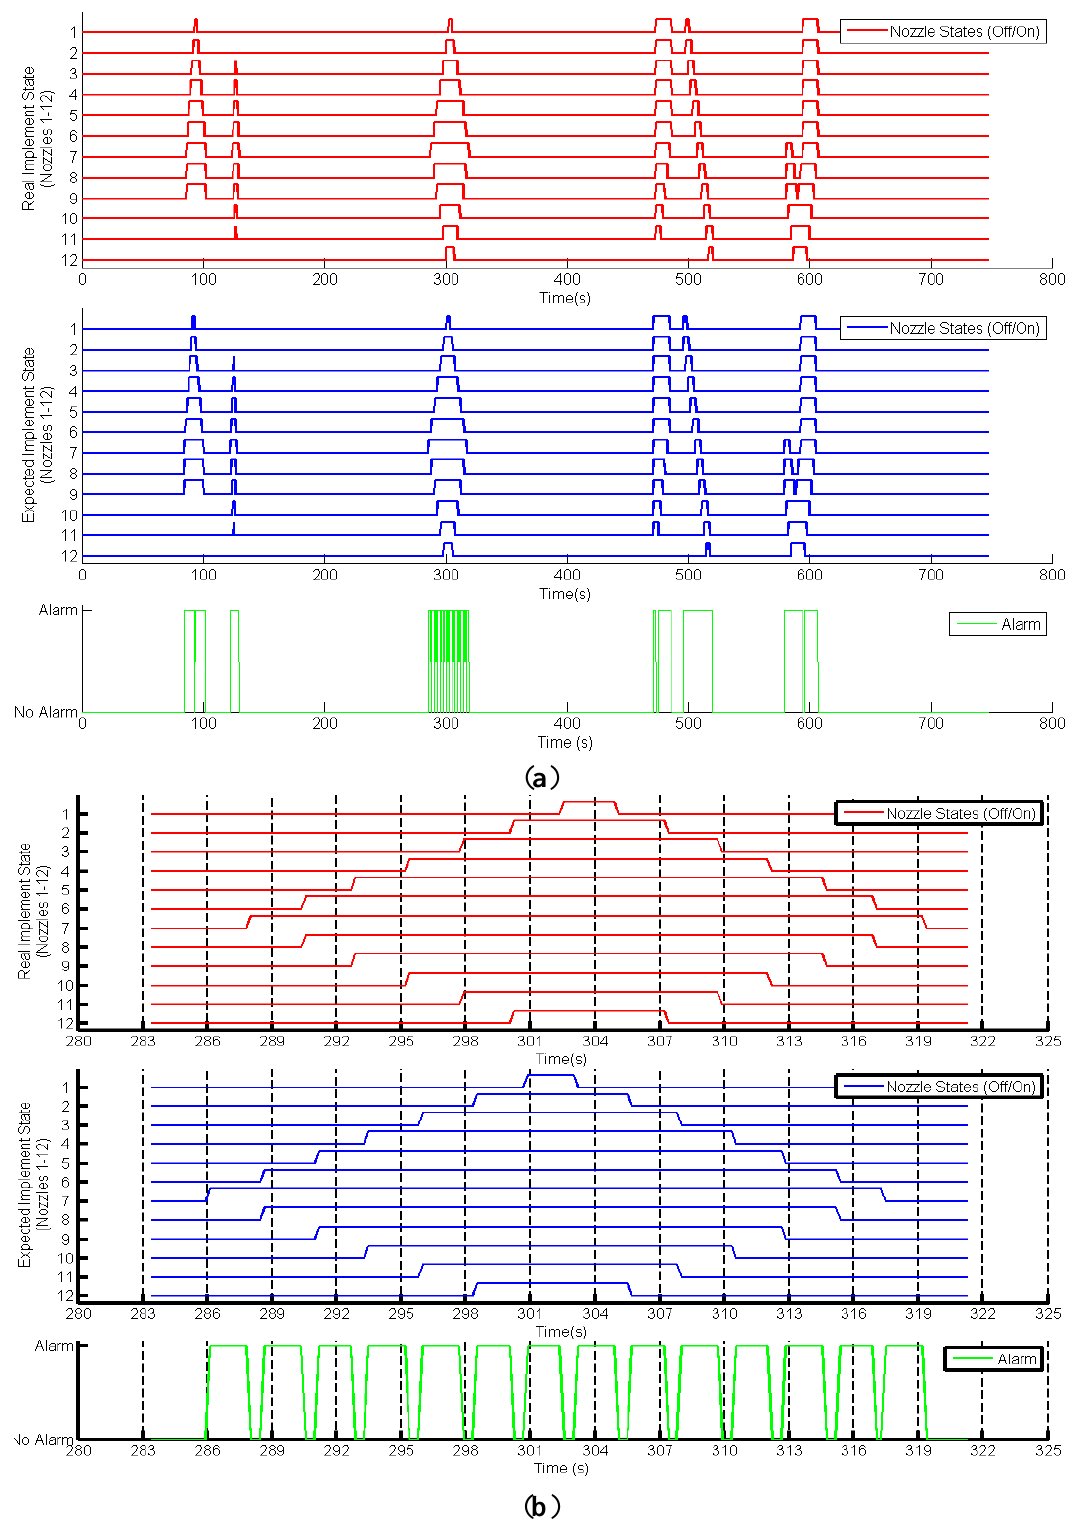
Figure 8. Implement supervisor inputs (actual and expected states) and outputs (alarm) ( a ) in the entire mission; and ( b ) in the mission interval from 283 s to 323